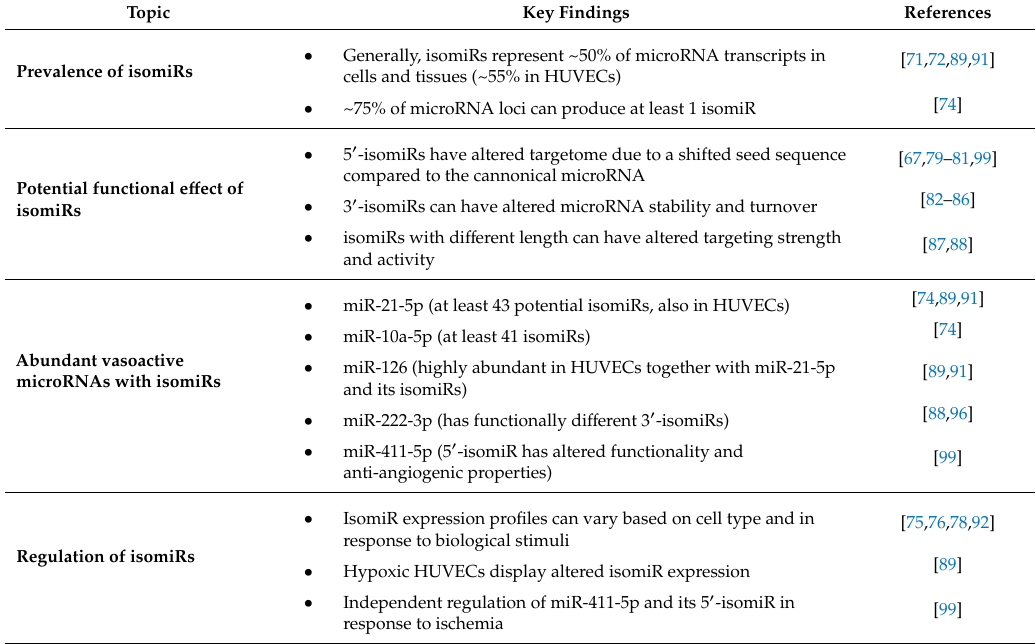
Table 1. Key studies demonstrating the prevalence and importance of isomiRs. Topic Key